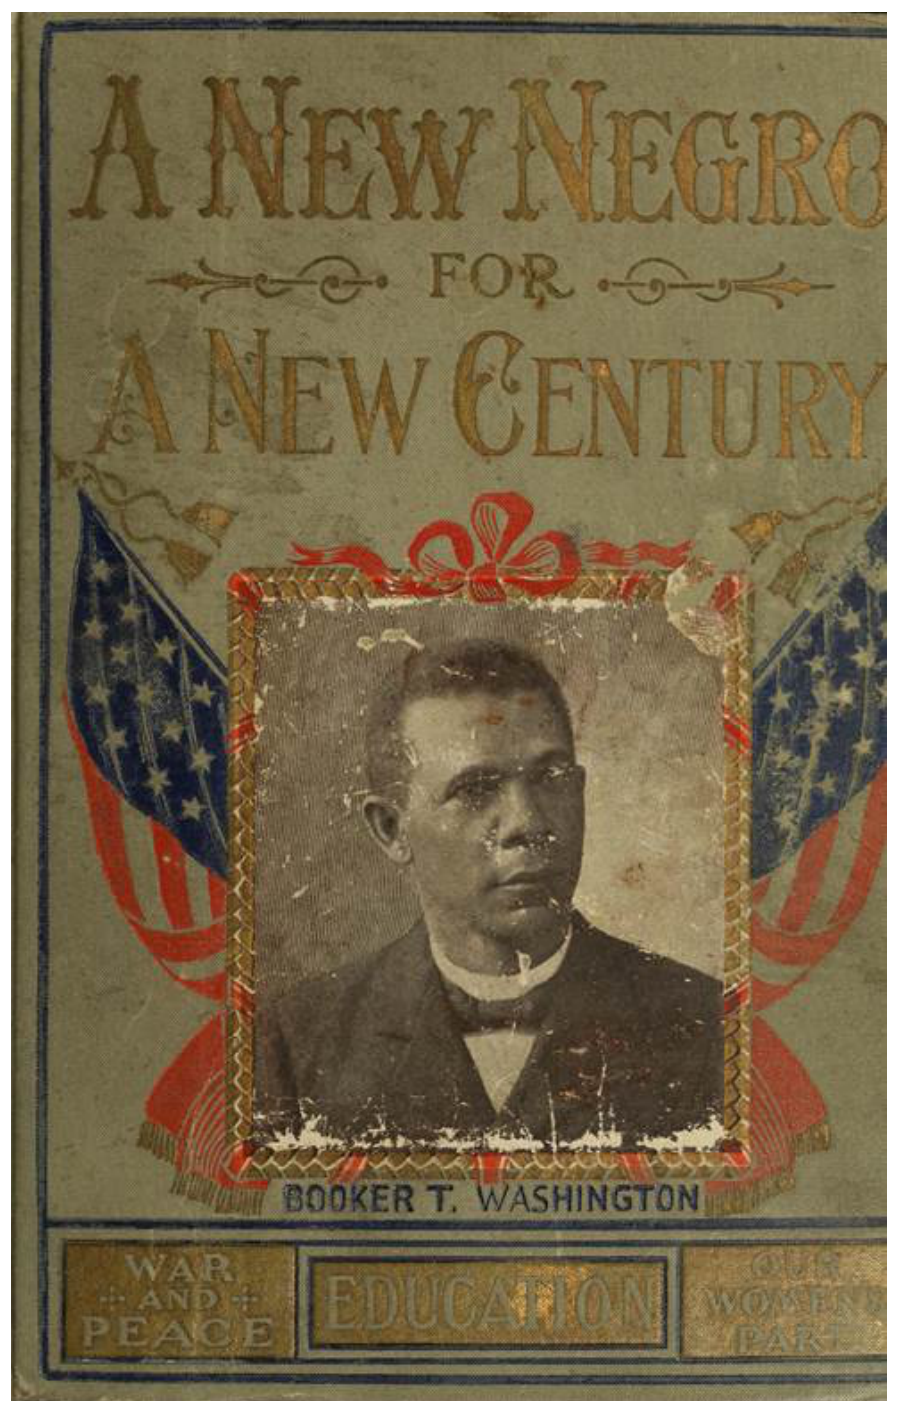
Figure 2 Front cover of A New Negro for a New Century (1900) with portrait of Booker T. Washington.